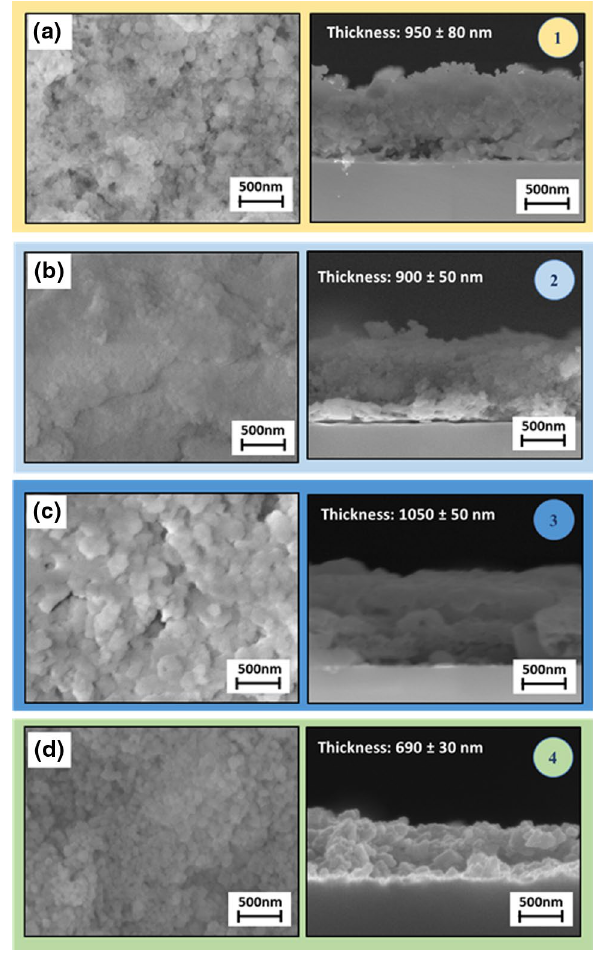
Fig. 3 FE-SEM plan and cross-sectional images of Cs-Ca films grown under different conditions: a route 1 with a molar ratio of the starting mixture 1: 1: 43: 1.5: 0.8, aging time 20 h, anneal- ing temperature 400 °C, on Si (100) substrate; b route 2 with a molar ratio of 1: 1: 43: 1.5: 0.8, 8 h, 400 °C, on Si (100); c route 3 with a molar ratio of 1: 1: 43: 1.5: 0.8, 8 h, 350 °C, on Si (100); d route 4 with a molar ratio of 1: 1: 43: 1.5: 0.8, 20 h, 550 °C on